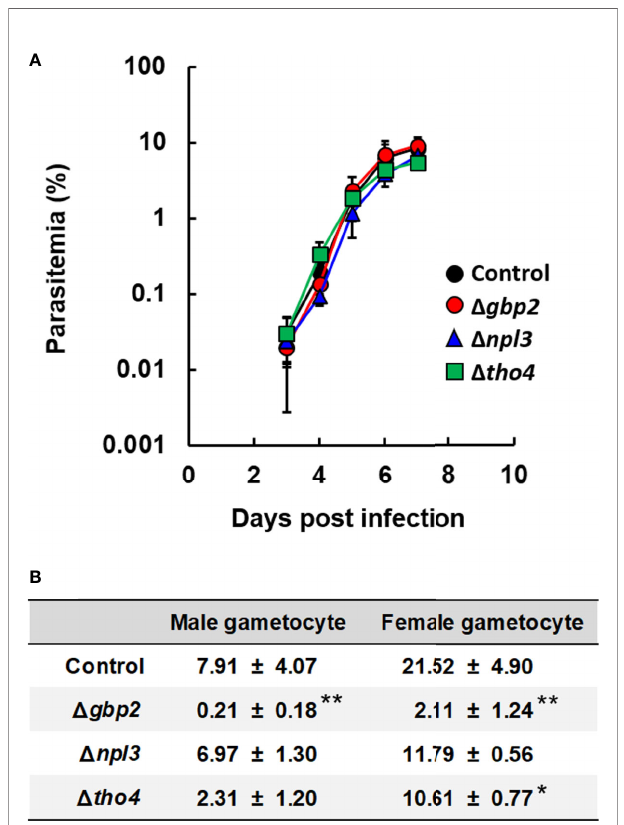
FIGURE 1 | Effect of RNA-binding protein deletion on the asexual and sexual development of P. berghei ANKA. (A) Time course of parasitemia. Female C57BL/6 (B6) mice were infected with 1 × 10 4 erythrocytes inoculated with P. berghei ANKA with gbp2 , npl3 , or tho4 deletion ( D gbp2 , D npl3 , or D tho4 parasites, respectively). As a control, P. berghei ANKA with a p230 deletion was inoculated intravenously into mice. Results are expressed as means ± standard deviation (SD) of three mice. Experiments using three mice were performed in duplicate. (B) Percentages of mature male and female gametocytes. Erythrocytes infected with malaria parasites were incubated for 28h. The percentages of male and female gametocytes were calculated as follows: [(number of male or female gametocytes) ÷ (total number of schizonts plus male and female gametocytes)] × 100. Results are expressed as the mean ± standard deviation of three independent experiments. * indicates a signi fi cant difference compared with the control parasites (Tukey-Kramer and Dunnett tests). ** indicates a signi fi cant difference compared with the control, D npl3 , and D tho4 parasites (Tukey-Kramer and Dunnett To examine the cellular localization of GBP2 and NAB2, we performed live-cell fl uorescence imaging of cultured GBP2:: mCherry and NAB2::mCherry schizonts and infected erythrocytes obtained from mice at 6 h (ring form), 12 h (trophozoite) and 18 h (late trophozoite) post-inoculation with GBP2::mCherry and NAB2::mCherry schizonts ( Figure 2 ). The mCherry signal was distributed throughout GBP2::mCherry parasite cells at all